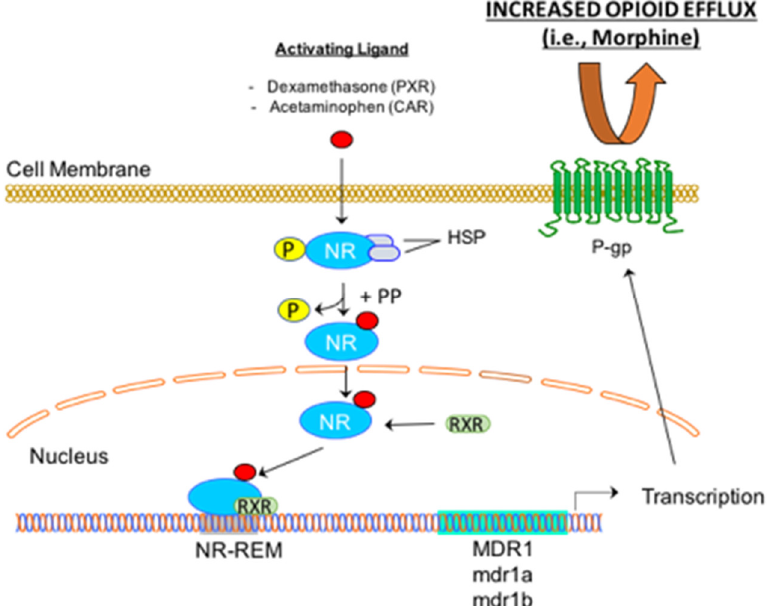
Figure 2. Mechanism of Nuclear Receptor Signaling in Brain Microvascular Endothelial Cells. At the blood-brain barrier, nuclear receptors can be activated by drugs used in the management of pain (i.e., dexamethasone, acetaminophen (APAP)). Once the ligand has bound to the nuclear receptor (NR), heat shock proteins (Hsp) dissociate and the NR is dephosphorylated by a protein phosphatase (PP). This process enables the NR to translocate to the nucleus and bind to its response element (NR-REM) on a target gene. This results in increased expression of ABC transporters such as P-glycoprotein (P-gp) at the endothelial plasma membrane, a mechanism that leads to reduced CNS accumulation of opioids that are transporter substrates.